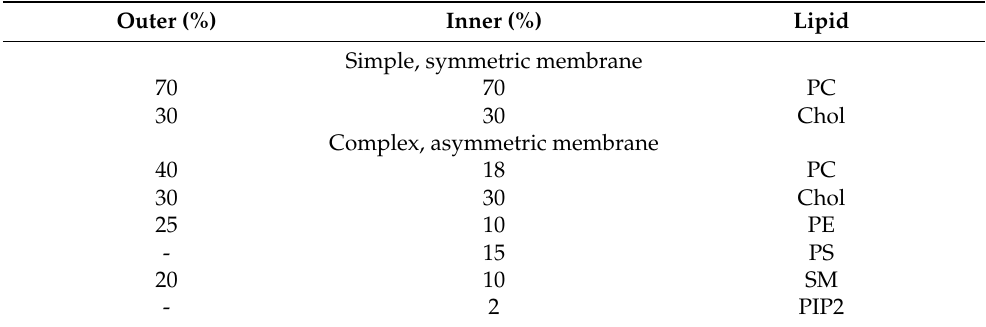
Table 1. Membrane compositions used in this study. The abbreviations used in this table are phos- phatidylcholine (PC), cholesterol (Chol), phosphatidylethanolamine (PE), phosphatidylserine (PS), sphingomyelin (SM) and phosphatidylinositol bisphosphate (PIP 2 ). Outer (%) Inner (%) Lipid Simple, symmetric membrane 70 70 PC 30 30 Chol Complex, asymmetric membrane 40 18 PC 30 30 Chol 25 10 PE - 15 PS 20 10 SM - 2